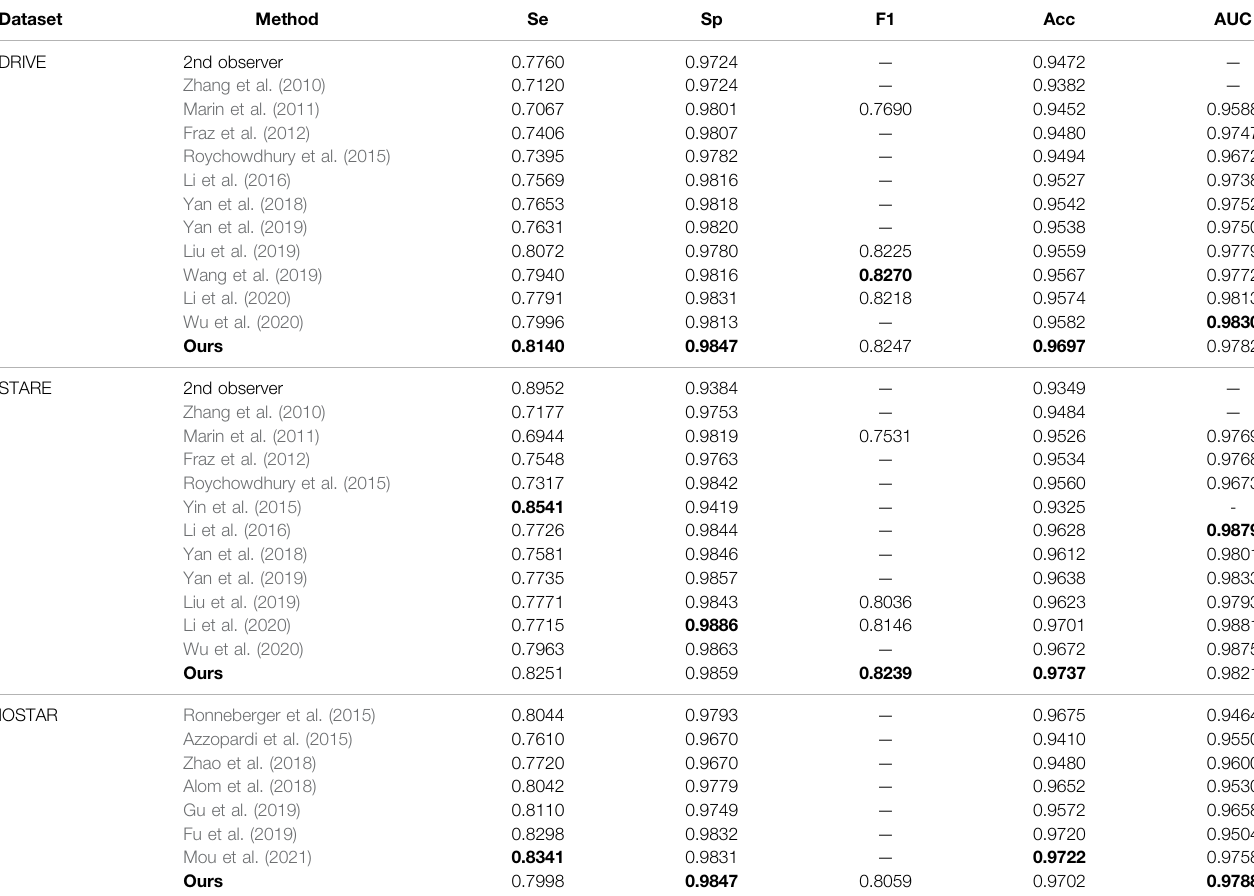
TABLE 5 | Comparison of different retina vessel segmentation methods on DRIVE, STARE and IOSTAR datasets.